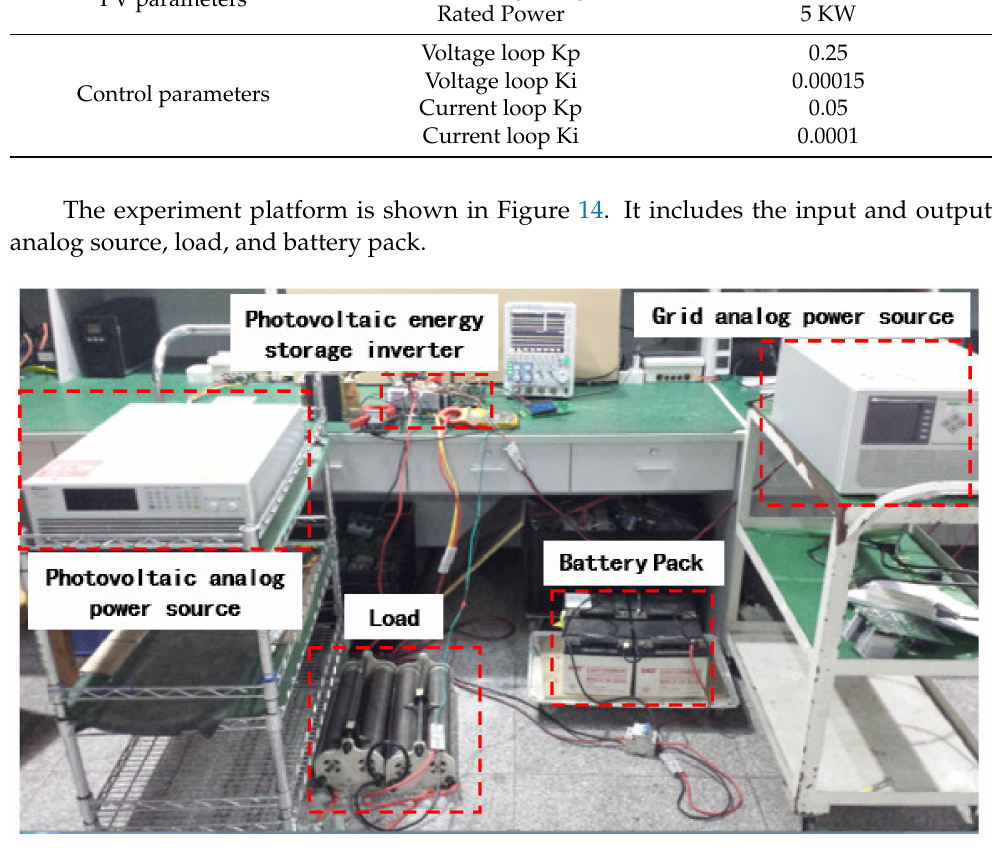
Figure 14. Experiment